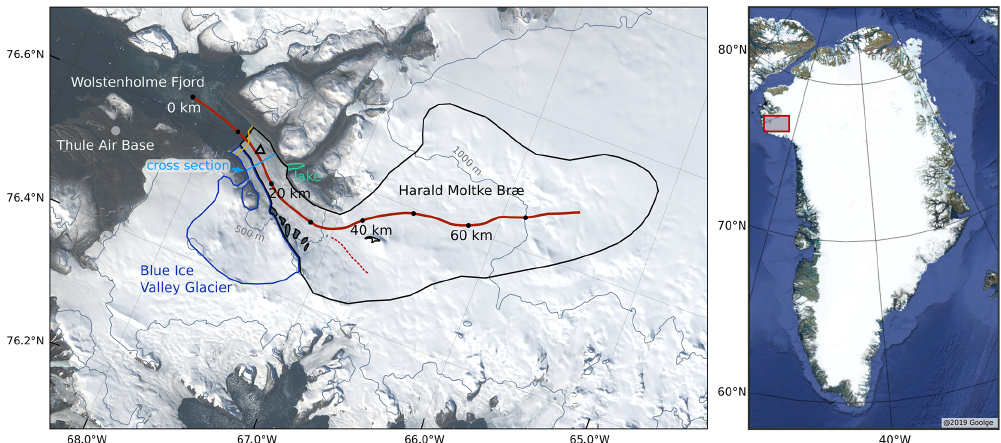
Figure 1. Region of investigation as viewed in a Landsat 8 scene of August 2014 (USGS, 2019) (see red box in the right image for its location in Greenland). Blue and black lines mark the drainage basins of Blue Ice Valley Glacier and Harald Moltke Bræ, respectively. Red lines (solid and dashed) mark the approximate centre line of the main glacier stream and of a tributary, respectively. The starting point of the centre line is at the mean position of the glacier front line in 1916 (year of the first available record of the front position). We use the glacier front position of 1916 as a reference for all longitudinal profiles and glacier front positions. The yellow line marks the approximate front positions of 2020. The black triangle marks the point (67.628 ◦ W, 76.588 ◦ N) to which all velocity time series in this paper refer. Table 1. Overview of the technical details of the velocity data sets from Landsat, Sentinel-1 (D), Sentinel-1 (P) and TerraSAR-X. The velocity fields are given in the form of regular spatial grids. The time basis refers to the acquisition time difference of the image pairs used for the velocity determination. The time difference denotes the interval between two consecutive velocity fields. Data set Landsat Sentinel-1 (D) Sentinel-1 (P) TerraSAR-X Time